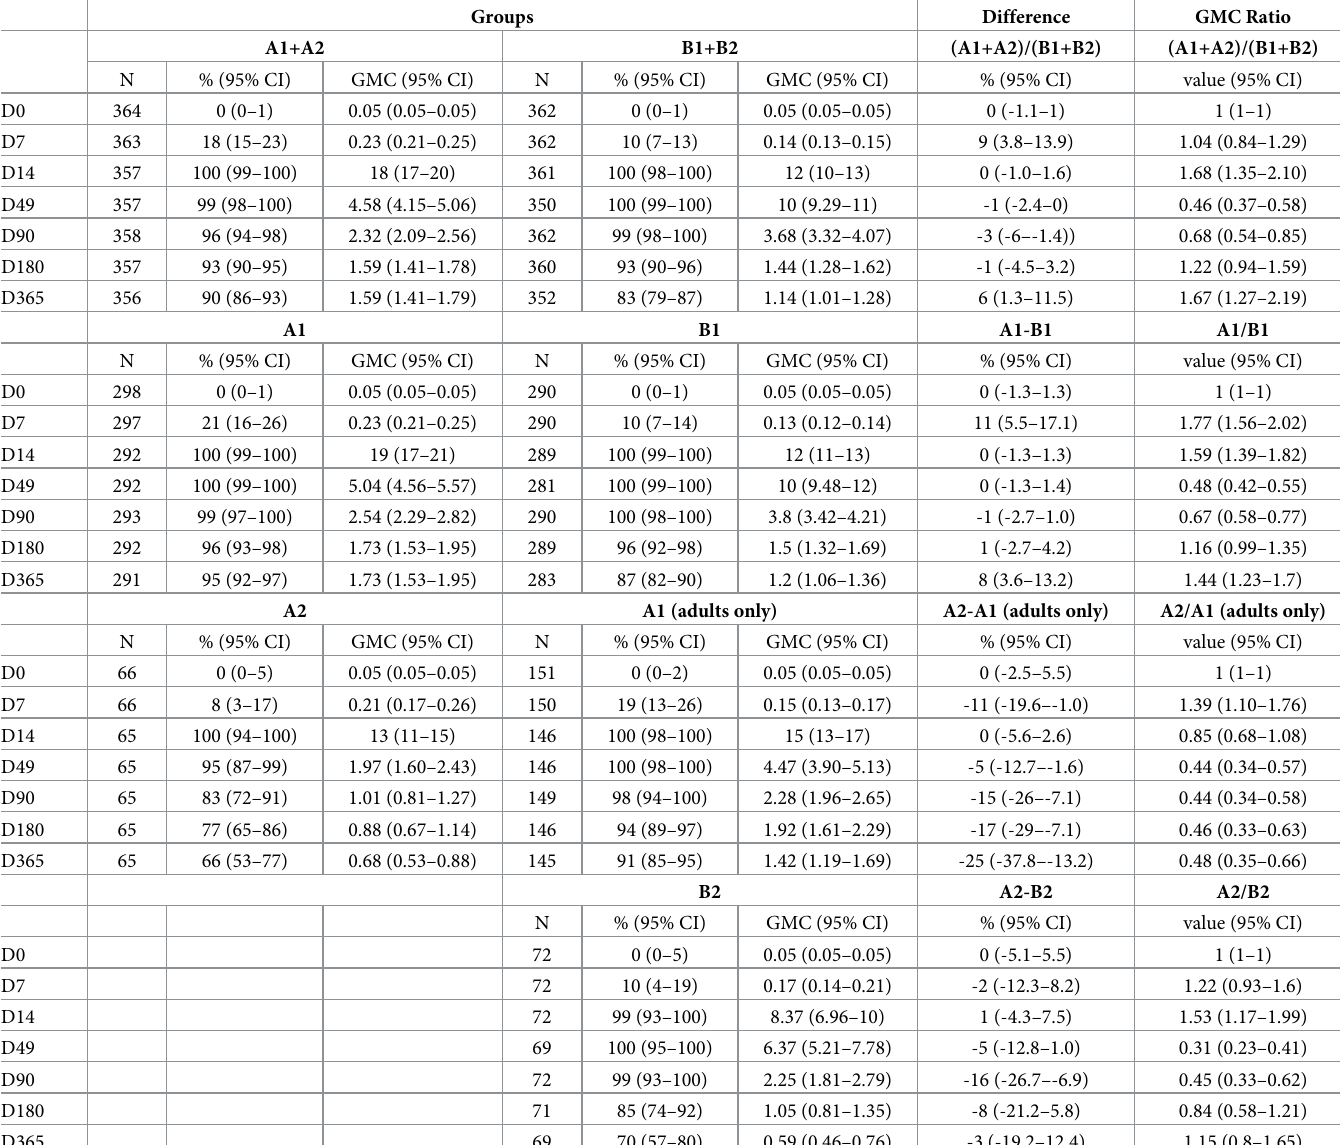
Table 2. Summary of between-groups comparison of immune response to different PCECV regimens in terms of percentage of participants with RVNA concentra- tions (cid:21) 0.5 IU/mL and GMCs (per-protocol set at each time point).